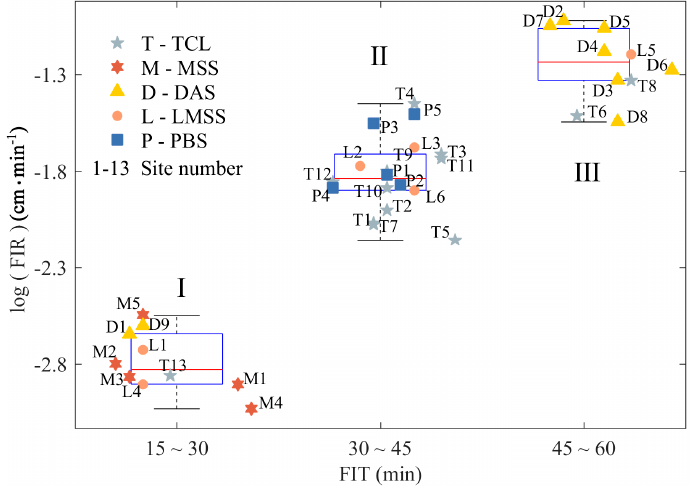
Figure 7. Regrouping of log-transformed final infiltration rate (FIR) and final infiltration time (FIT) at each infiltration site.